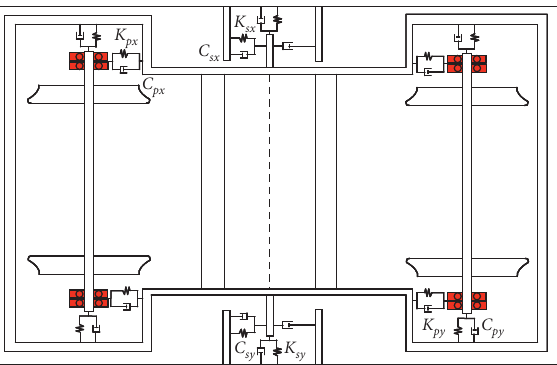
Figure 2: Lateral vehicle-track coupled dynamics Table 1: Main parameters of vehicle model.